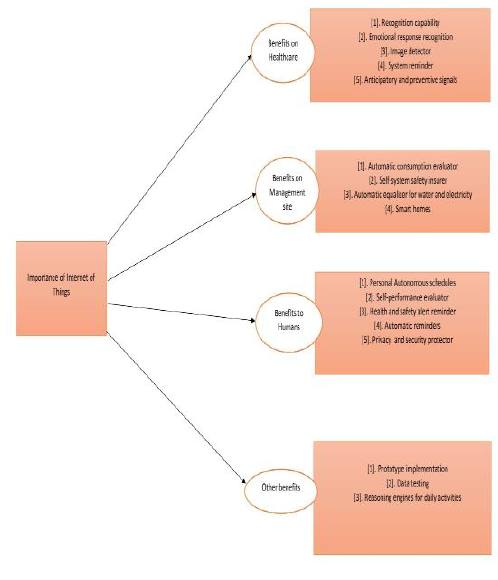
Figure 3. other importance of IoTs on human psychology for education, healthcare, and businesses. Source: